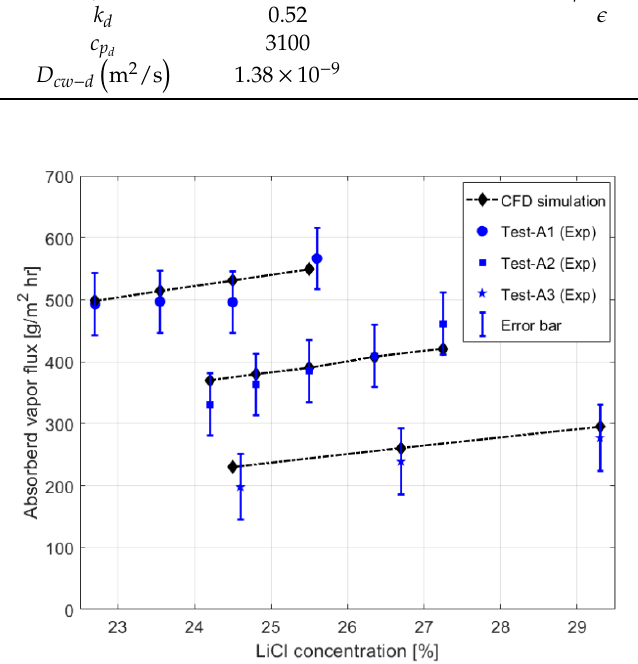
Figure 3. Experimental data vs. CFD simulation.